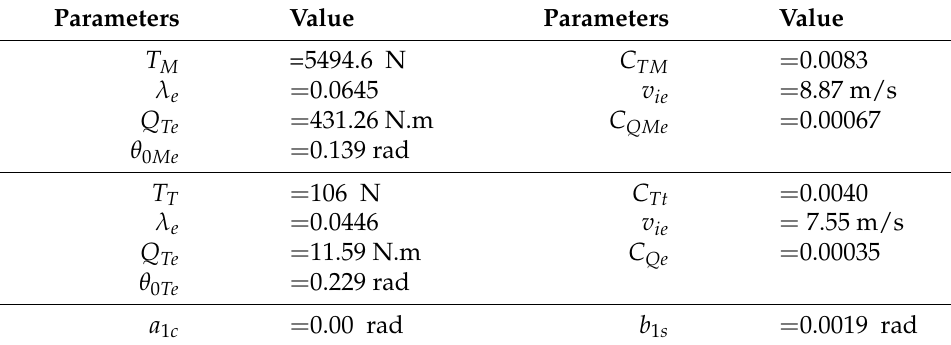
Table 5. The system parameters used for the trim numerical simulations.